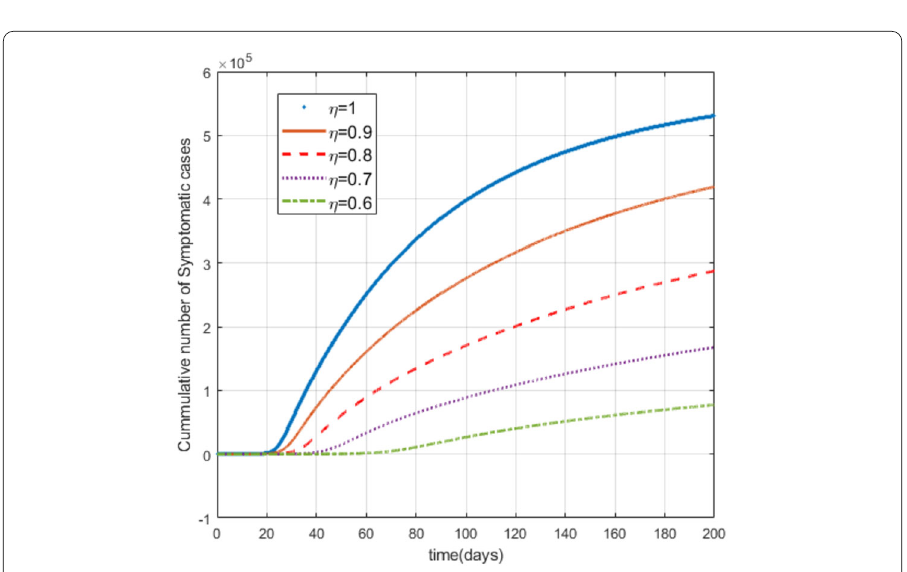
Figure 5 Total number of symptomatic cases (I) for different values of η